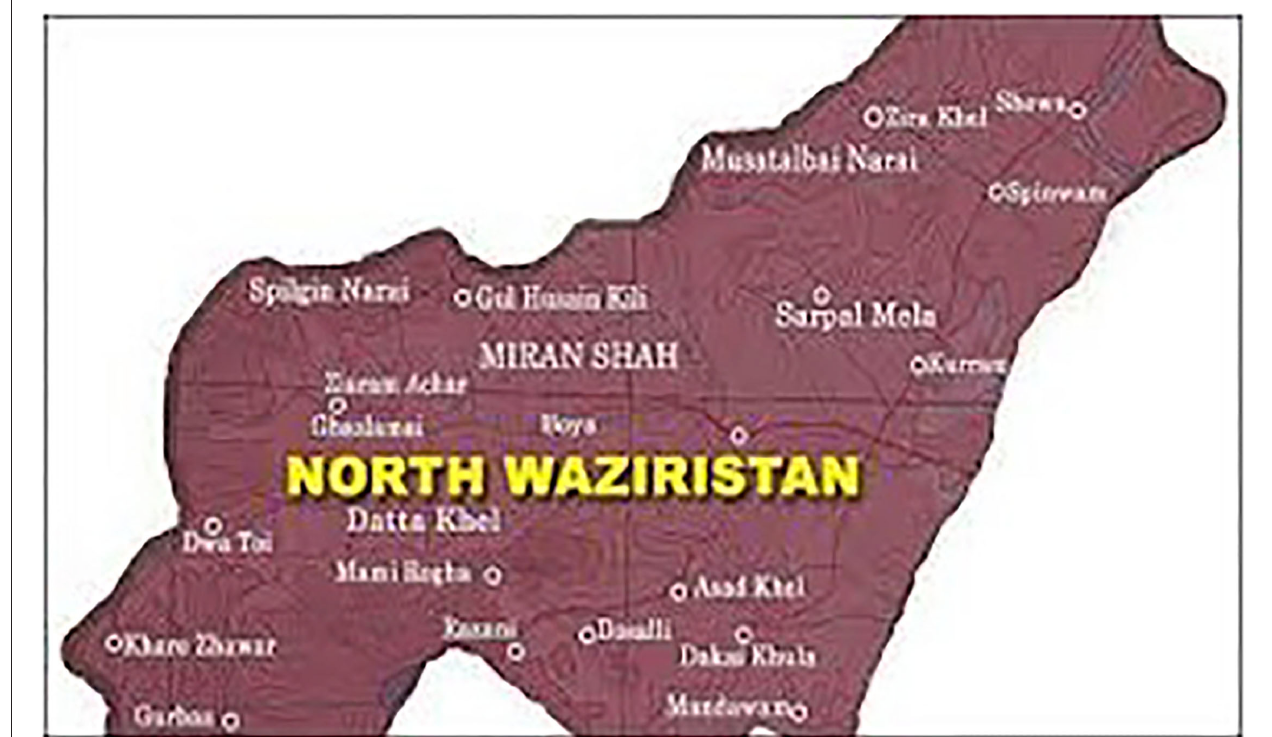
FIGURE 1 | Map of the study